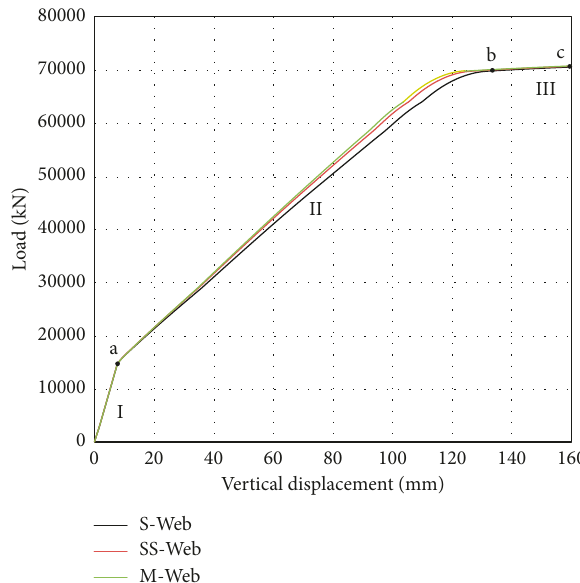
Figure 14: Load-displacement curves at